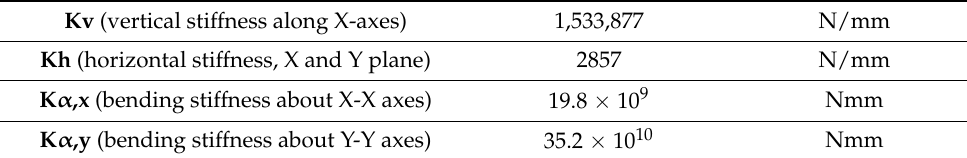
Table 5. Stiffness parameters of neoprene supports.